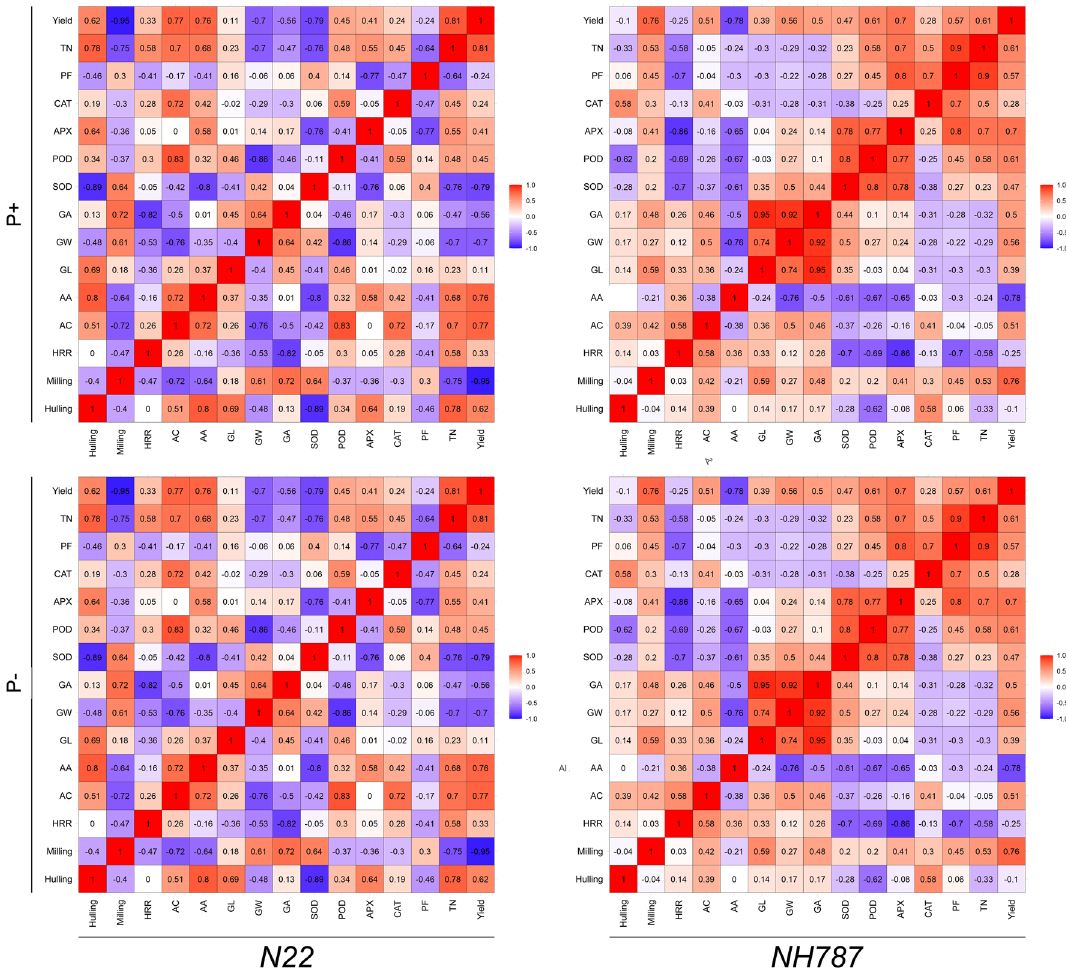
50% flowering under P+ and P− conditions. The scale represents Pearson correlation values with brownish and bluish shades indicate positive and negative correlation, respectively. TN Tiller number, PF pollen fertility, GA grain area, GW grain width, GL grain length, AA α-amylase, AC amylose content, HRR head rice